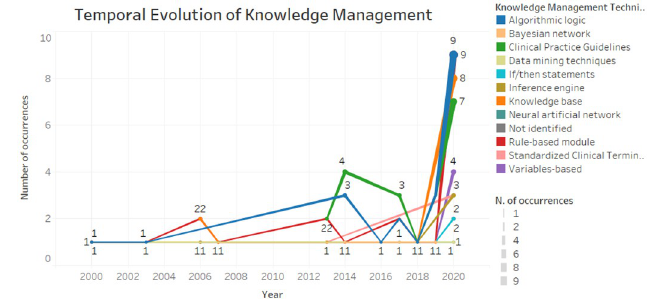
Fig 4. Temporal evolution of knowledge management.